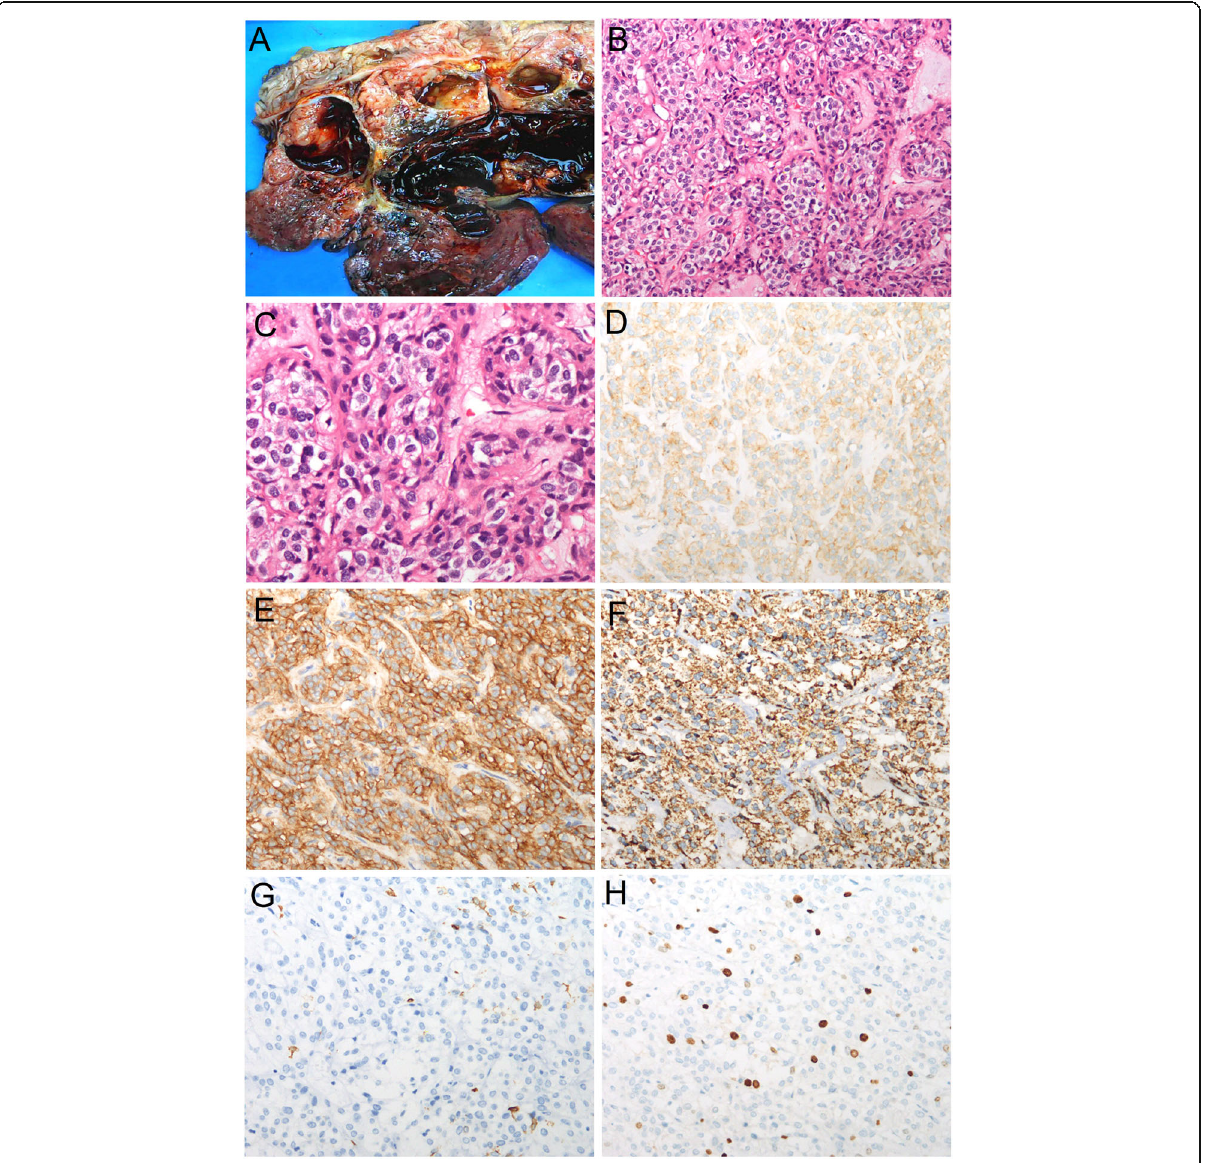
Fig. 2 Gross and microscopic images of the GIST. This tumor possessed both cystic and solid components. The cystic cavity was filled with dark brown blood, and the solid areas were delicate in texture ( a ). Sections of the mass were observed under a microscope, and the tissue was characterized by epithelioid tumor cells that were arranged in a prominent nesting pattern ( b , H&E stain, 100×). Images of epithelioid tumor cells stained by H&E under a high-power field are displayed in c (200×). The tumor cells exhibited a positive cytoplasmic signal for CD117 ( d , IHC, 200×), DOG-1 ( e , IHC, 200×) and SDHB ( f , IHC, 200×), and they were negative for SMA ( g , IHC, 200×). The Ki-67 labeling index was estimated to be 10% ( h , IHC,